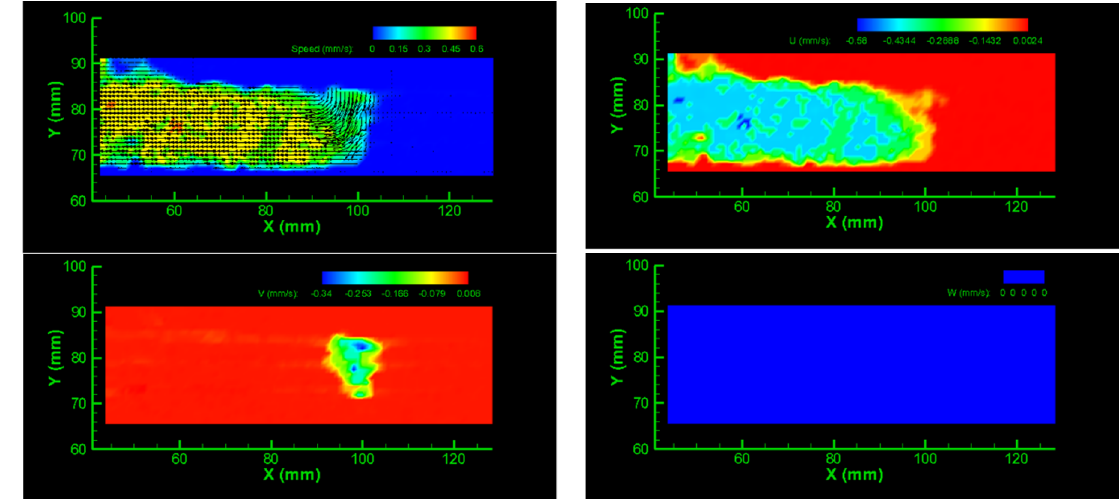
Figure 4. The instantaneous velocity profiles of the particles measured by the PIV technique (U, V, and W are the velocities in x-, y- and z-coordinates, respectively).